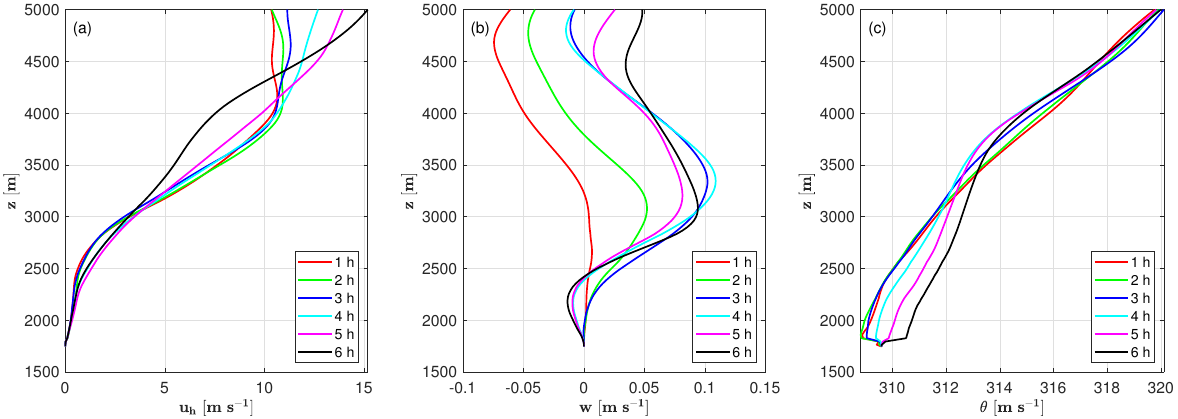
Figure 7. Horizontal mean vertical profiles of ( a ) horizontal wind speed, ( b ) vertical wind speed and ( c ) potential temperature at the whole domain in time after the start of the simulation at 06:00